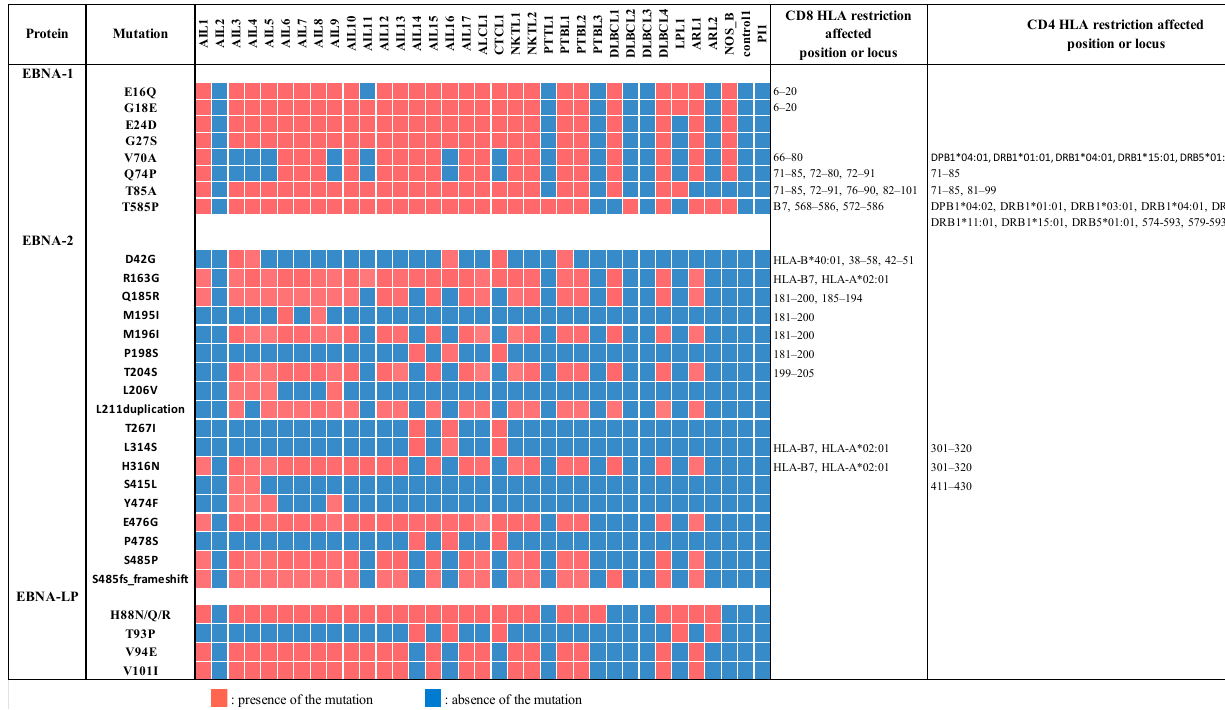
Figure 9. Main mutations observed among the latency proteins EBNA-1, EBNA-2, and EBNA-LP. CD8- and CD4-HLA restriction-affected position or locus are mentioned. Mutations of AIL18, which is an EBV-2, are not reported.